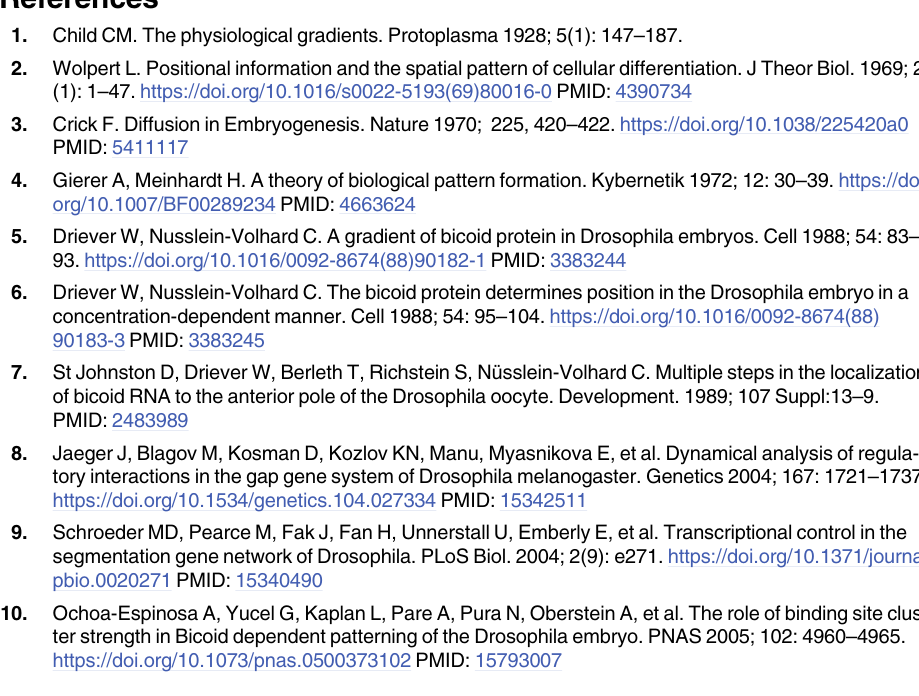
S5 Fig. The key differences between 13th cycle and early 14th cycle both for the bcd mRNA profiles and for the Stau factor profiles.